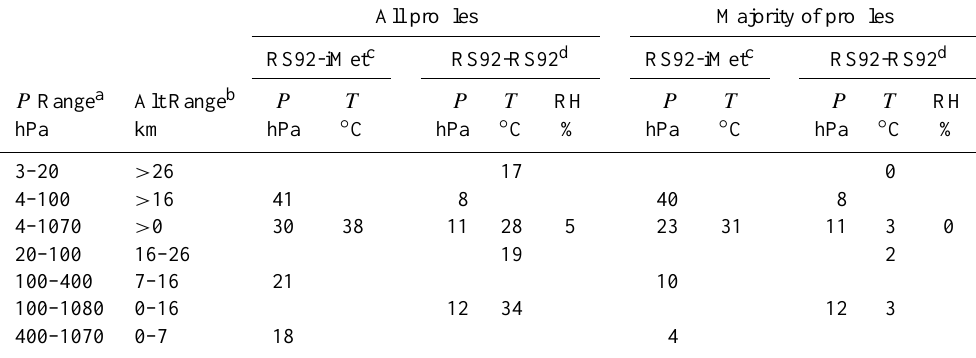
Table 4. Percentages of differences exceeding radiosonde measurement uncertainties. All profiles Majority of profiles RS92-iMet c RS92-RS92